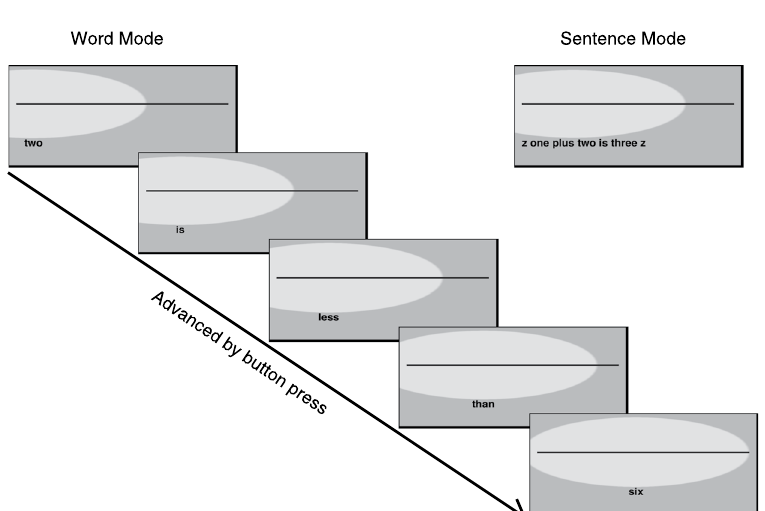
Figure 7. Schematic of experimental protocol (approximately to scale for the largest text size used, but with the lower part of the screenshots truncated), for one trial of both Word Mode and Sentence Mode. On the experimental display monitor, the simulated scotoma (shown here as a light grey ellipse) was the same luminance and colour as the background (shown here as mid-grey). In this schematic, a true statement is shown for both